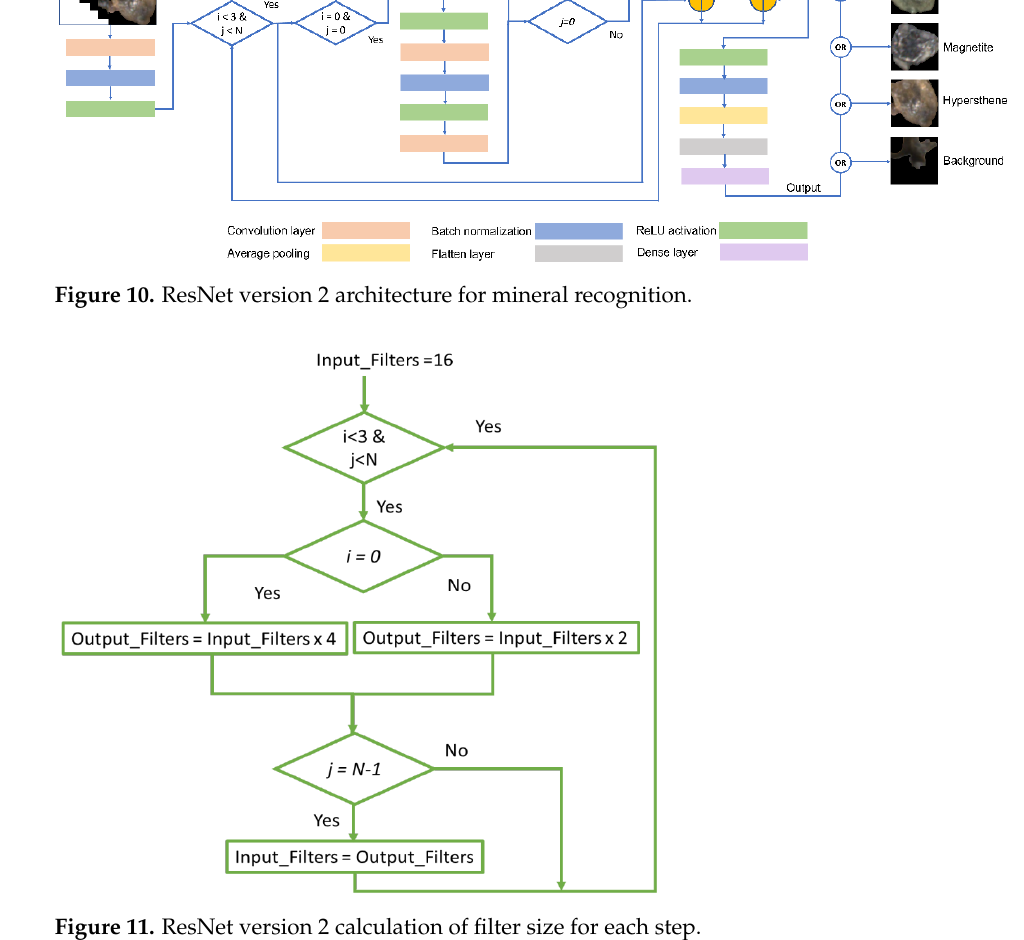
Figure 11. ResNet version 2 calculation of filter size for each step.